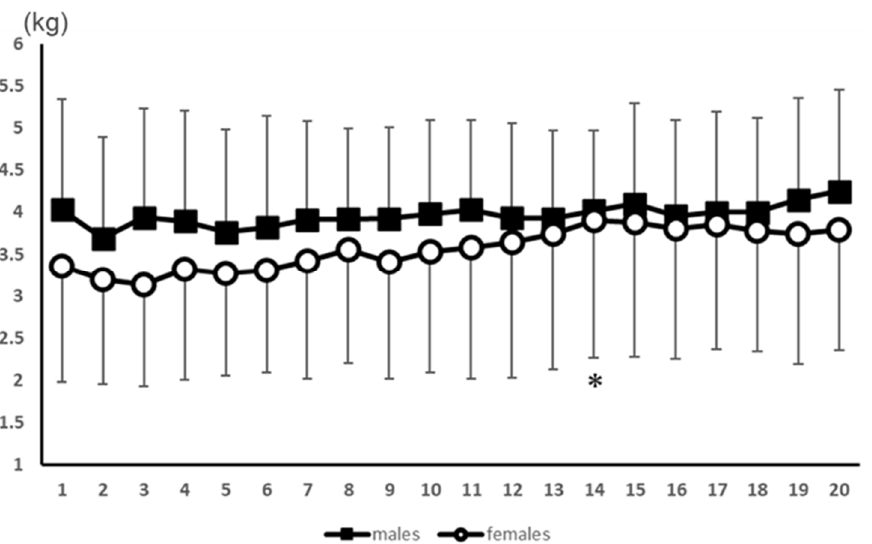
Figure 3. Results of the PPT values for the ankle plantar flexors for 20 consecutive measurements. *: Significant difference from the 5th measurement in females.